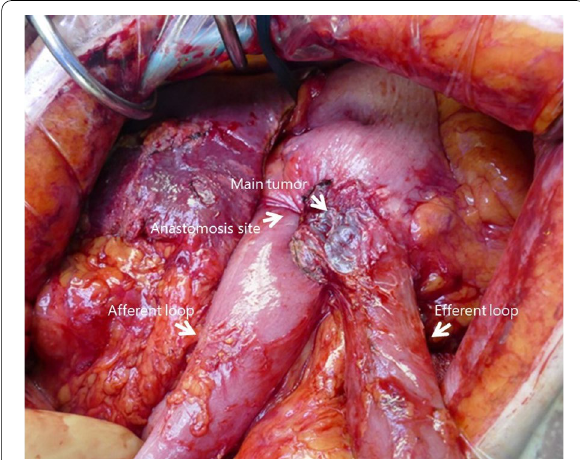
Fig. 4 The picture in the operation. Reconstruction in the former operation was performed in antecolic Billroth II fashion without Braun’s